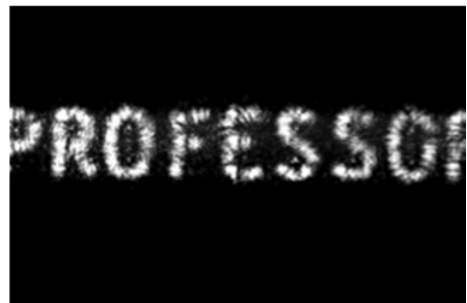
Figure 3. Input object captured by camera. Here the slide with the word “PROFESSOR” is placed directly to the detector. The size of the object slightly exceeds the size of the detector.